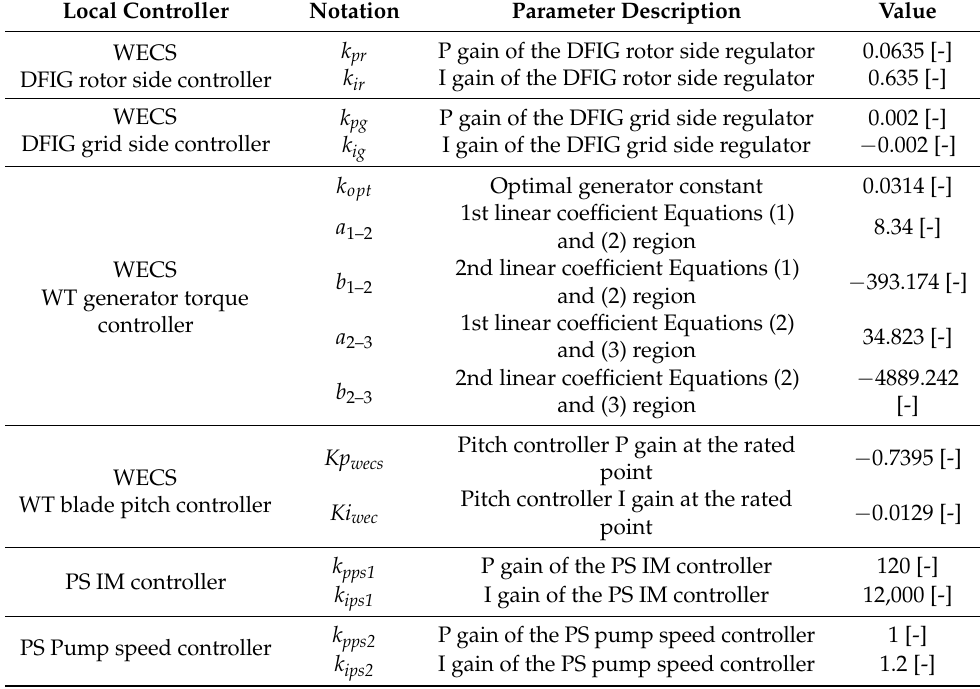
Table A2 presents the parameters and gains of each local controller. Table A2. Calculated controller